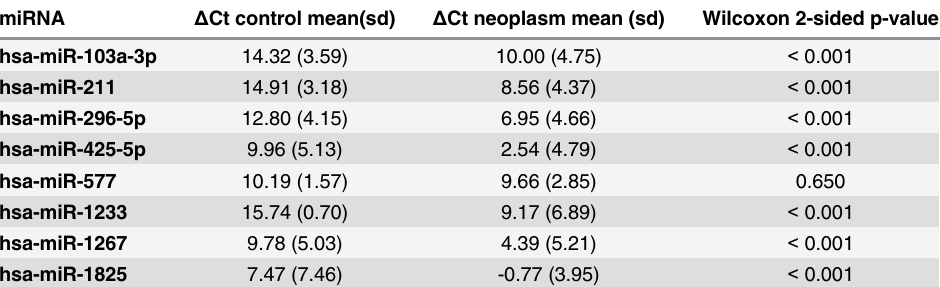
Table 3. Mean Δ Ct (sd) and Wilcoxon 2-sided p-values of validated salivary miRNA biomarkers. The independent validation sample set consisted of whole saliva samples from patients with a parotid gland neo-